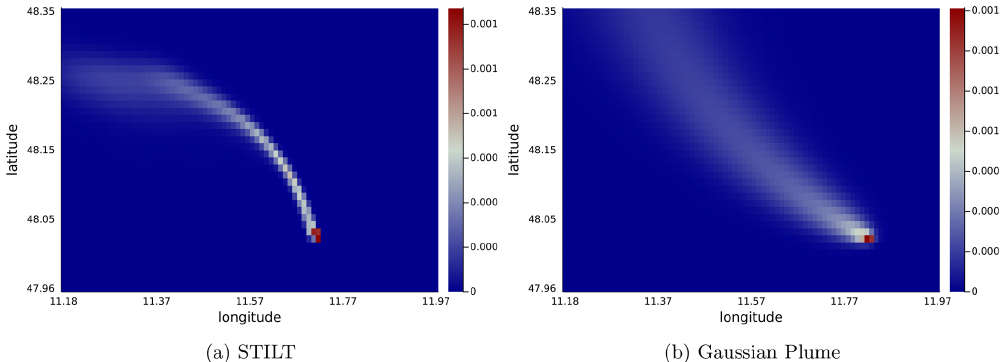
Figure B1. Comparison of a STILT footprint to a Gaussian plume footprint, where different wind fields have been used.